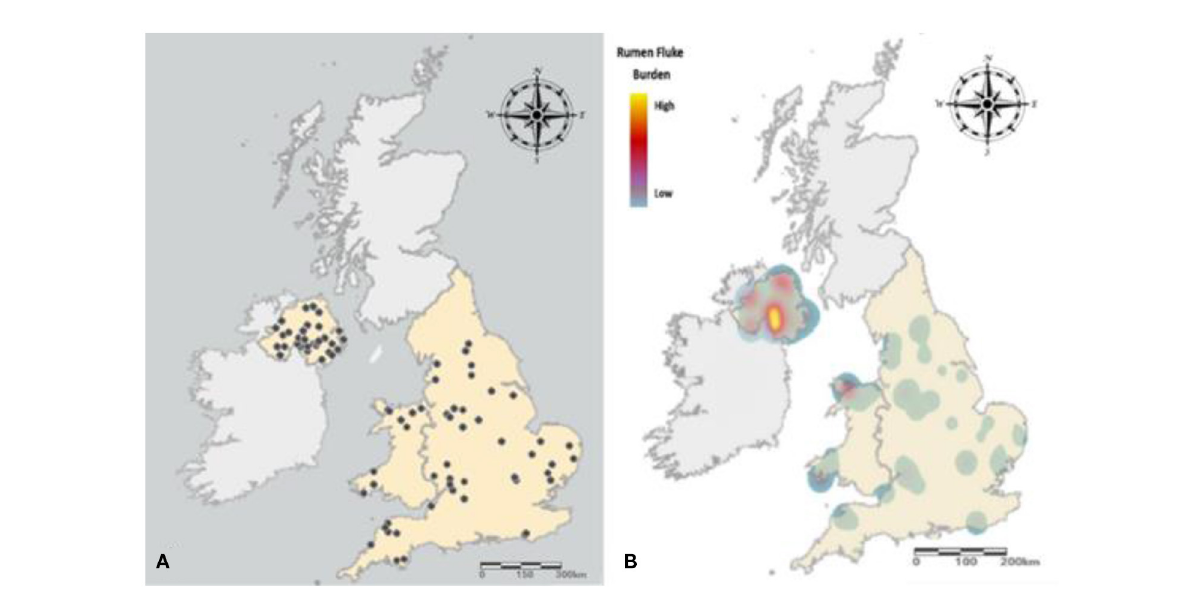
FIGURE3 Distribution and prevalence of cattle carcases positive for rumen fluke. (A) Farm origin of cattle carcases infected with rumen fluke. (B) The prevalence and burden of rumen fluke infection experienced across England, Wales and Northern Ireland. A low burden ( < 50 flukes) is represented by blue, with the rise in color gradient synonymous with an increase in rumen fluke burden, with a very heavy burden ( > 1,000) represented by yellow.